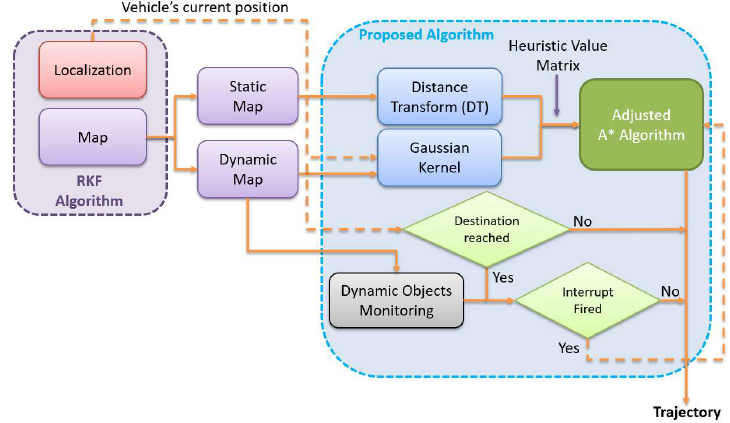
Figure 1. Overview of the system structure.